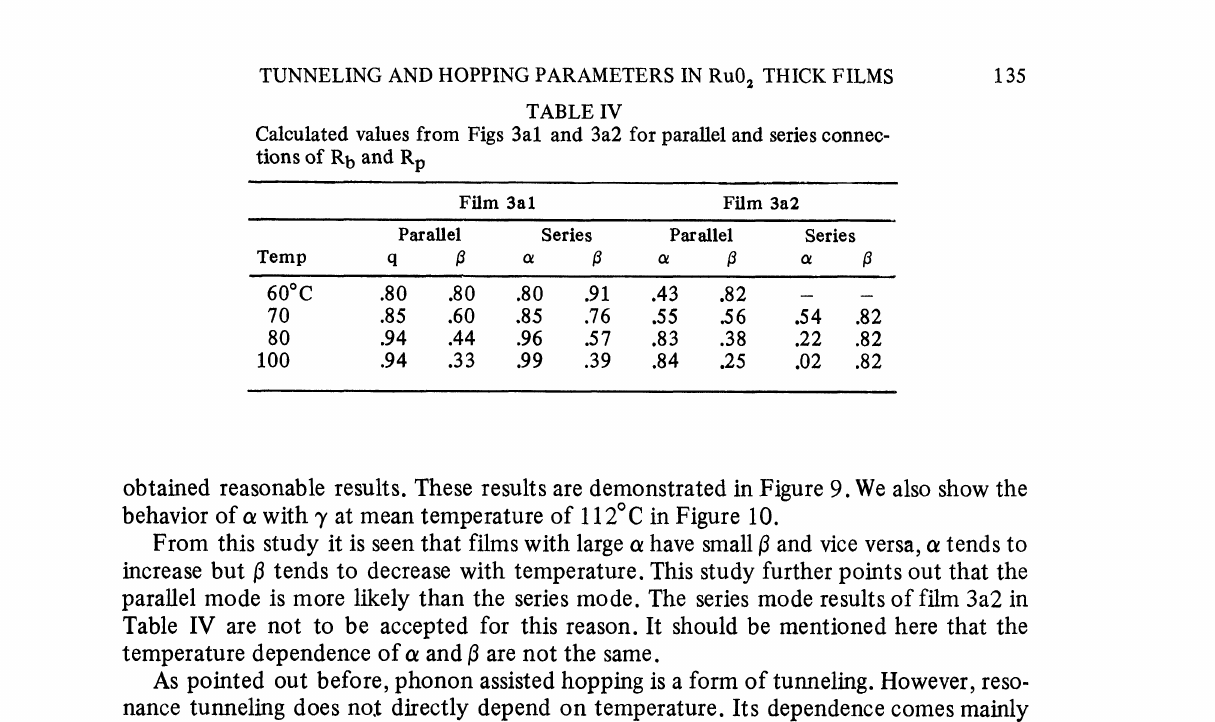
TABLE IV Calculated values from Figs 3al and 3a2 for parallel and series connec- tions of R b and